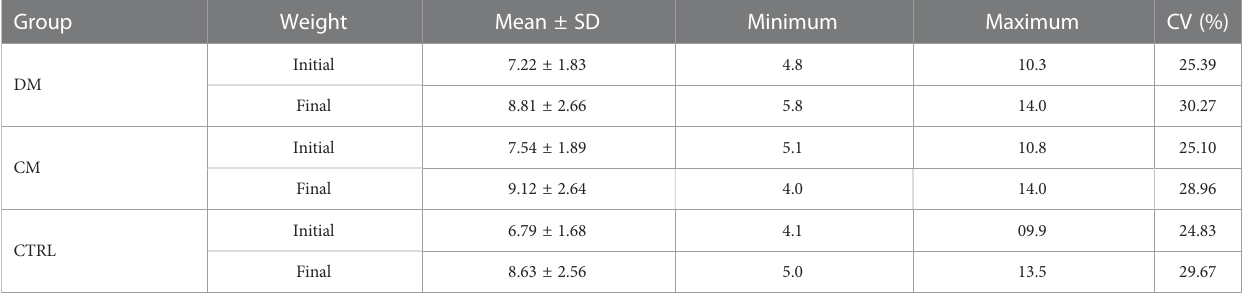
TABLE 6 Descriptive statistics of the piglet ’ s body weight f (N=16) before (initial) and after ( fi nal) supplementation of asinine milk (DM), skimmed cow milk (CM) and no supplementation (CTRL). Group